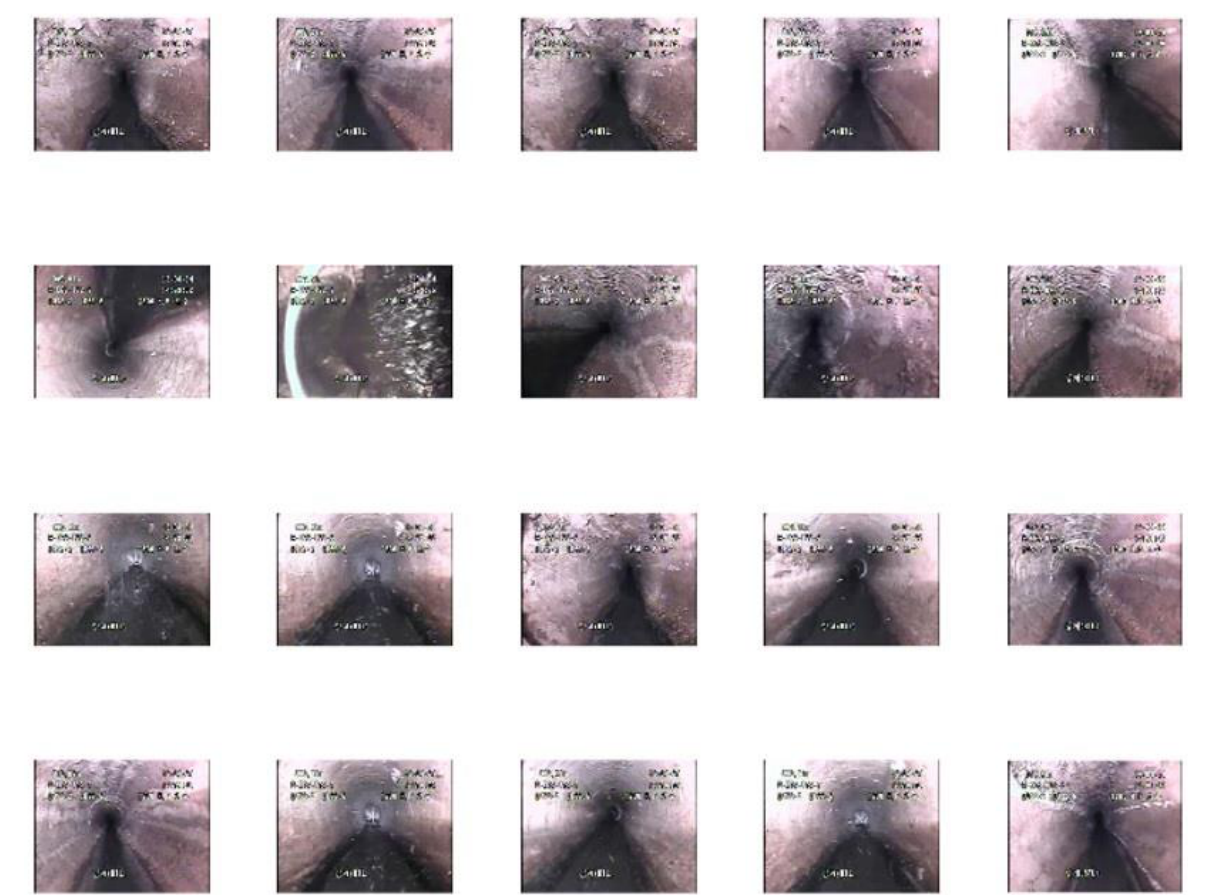
Figure 2. Sample images of non-cracks.